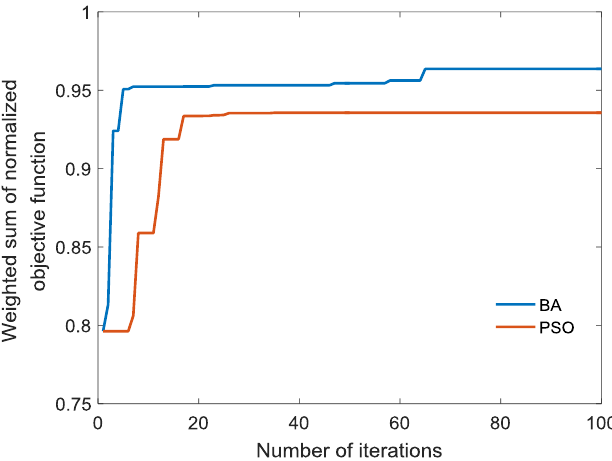
Figure 8. Convergence curves of two algorithms.